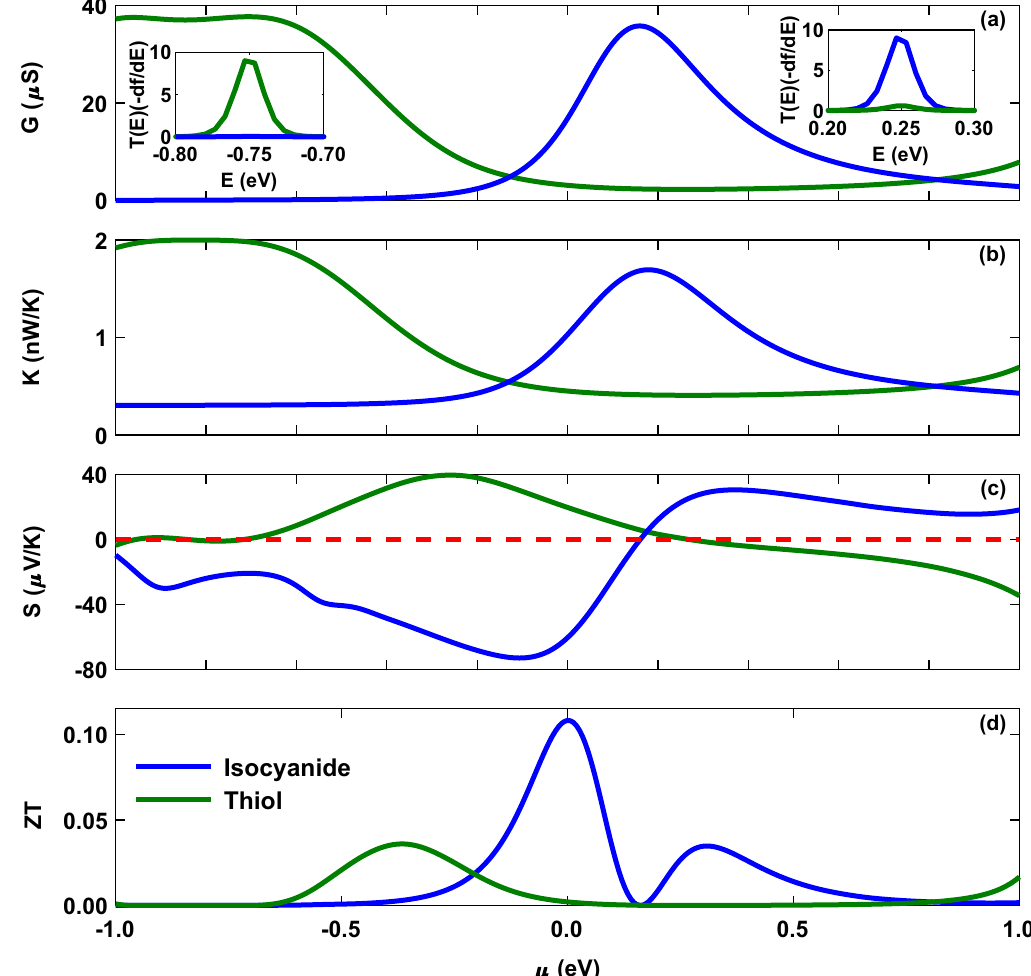
Figure 3. Thermoelectric coefficients of the Au-anthracene-Au junction as a function of the chemical potential of the electrodes with thiol (green) and isocyanide (blue) anchoring groups. ( a ) Electrical conductance, ( b ) thermal conductance, ( c ) thermopower (with S = 0 in red dashed line as a reference) and ( d ) figure of merit evaluated at T = 300 K . Insets to panel ( a ) show T (ε)( − ∂ f /∂ε) as a function of